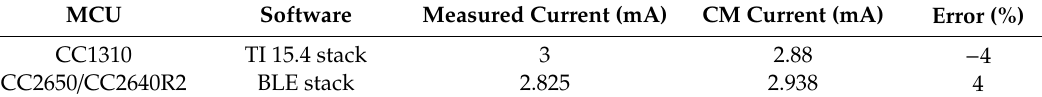
Table 2. Accurate current consumption estimation using CM.